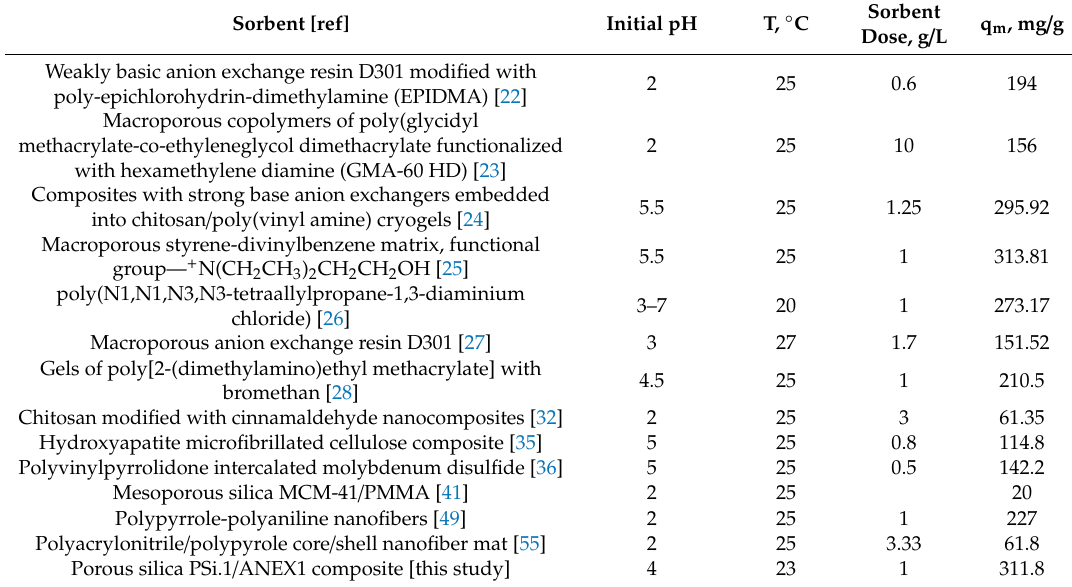
Table 3. Comparison of the maximum sorption capacity (Langmuir model) of the porous silica / ANEX composite sorbents for Cr(VI) removal with other sorbents recently reported in literature. Sorbent [ref] Initial pH T, ◦ C